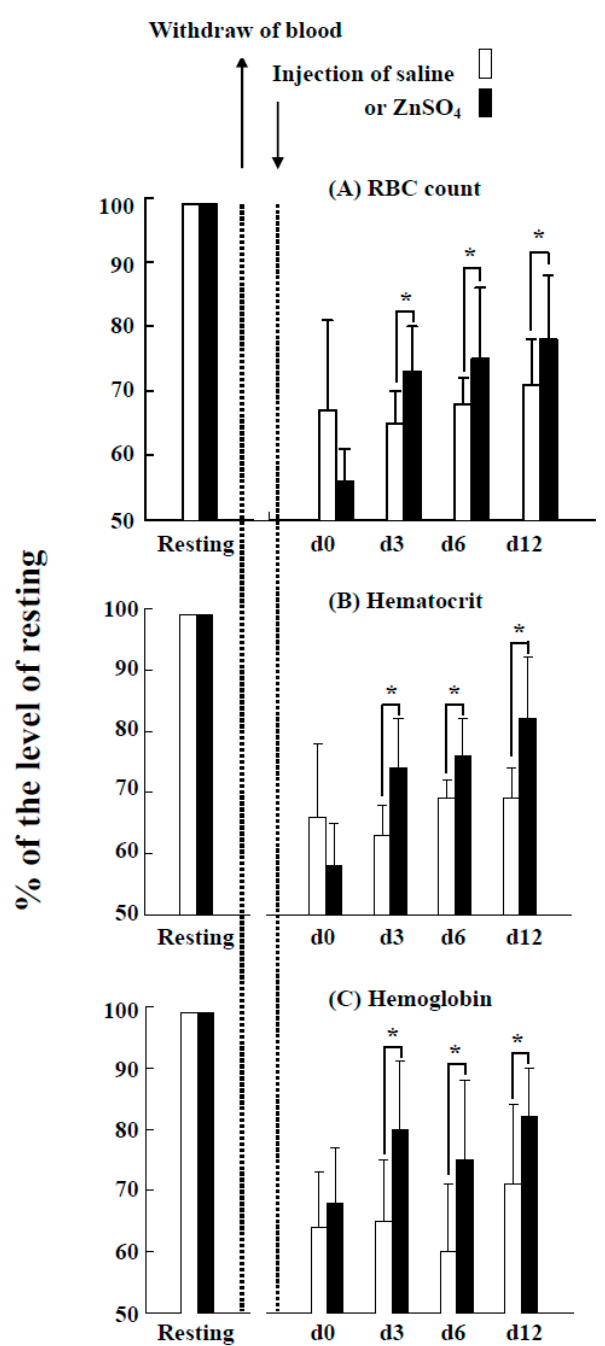
Figure 6. Effects of the injection of ZnSO 4 on erythropoiesis in the blood loss tilapia model. At day zero, blood was withdrawn from the fish, and saline or ZnSO 4 was injected. At day three, day six, and day 12, blood was sampled from the treated fish and analyzed. The data are expressed as the ratios of the RBC count ( A ), hematocrit ( B ) and hemoglobin ( C ) level at different days to the values at baseline. The results are the means ± SDs of three independent experiments. * Significant difference ( p < 0.05) between the saline and ZnSO 4 treatments.